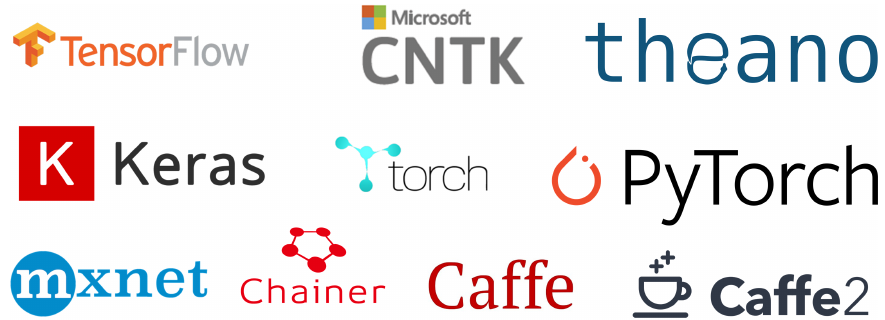
Figure 11. Some well-known ML/DL